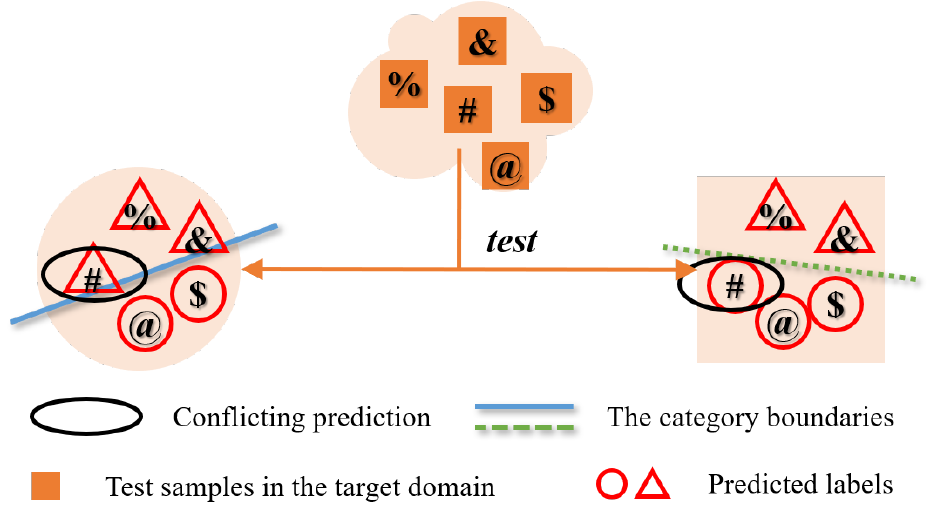
Figure 4. The demonstration the prediction conflict of domain-specific classifiers.